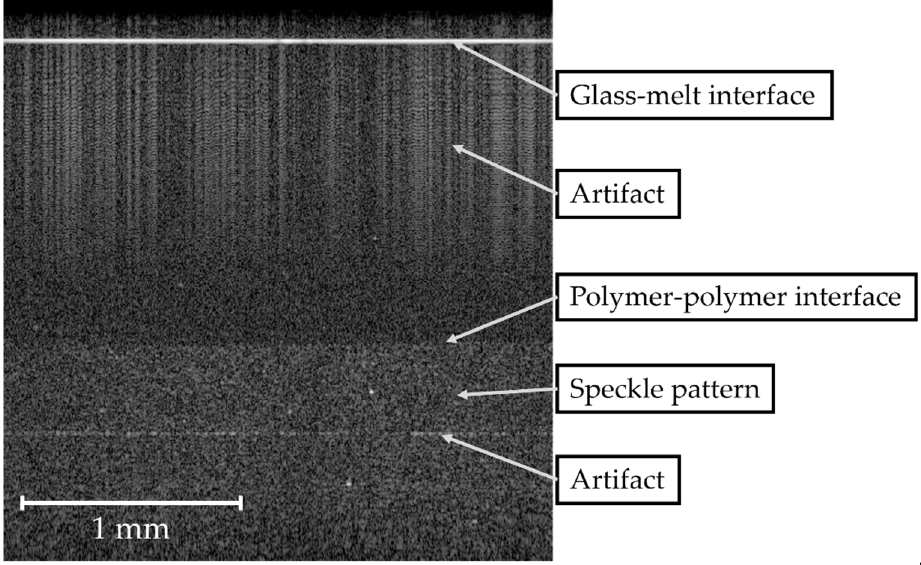
Figure 9. Image of an OCT measurement (B-Scan) during co-extrusion, showing glass-melt and polymer-polymer interfaces.